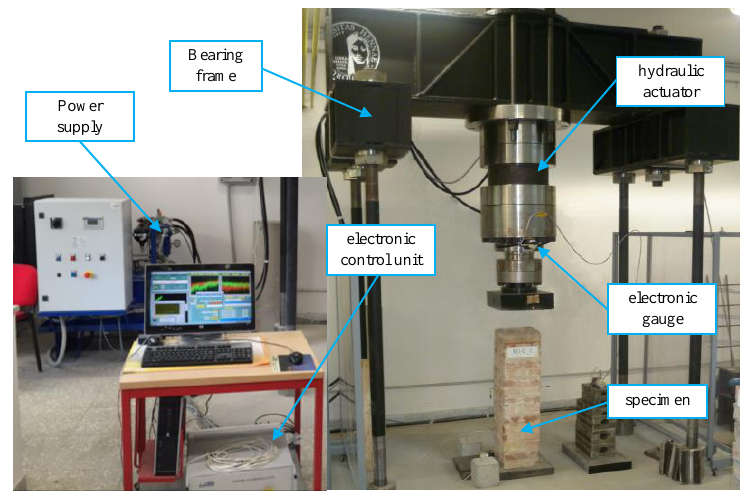
Figure 4. Test equipment and set-up.